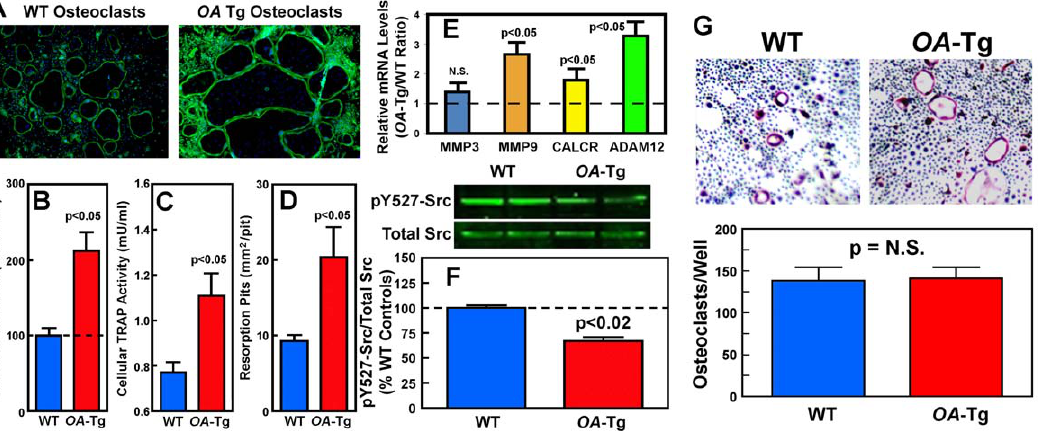
Figure 8. Effects of overexpression of OA on relative size of marrow-derived osteoclasts (A and B), and TRAP expression levels (C), size of resorption pits formed invitro (D), expression levels of bone resorption genes (E), cellular Src tyrosine-527 phosphorylation level (F), and number of TRAP-expressing osteoclast-like cells formed in response to the RANKL and m-CSF treatment (G). In A–F, marrow-derived osteoclasts were generated from treatment of unattached marrow cells of 12-weeks-old male adult OA -Tg mice and corresponding WT littermates with RANKL and m-CSF for 7 days. In A, to identify the size of osteoclasts, actin rings were stained with FITC-Palloidin and visualized under a fluorescent microscope. Results are shown in mean 6 SEM (n=3 each for each parameter). In G, marrow-derived osteoclasts were generated by treating unattached marrow cells of five 4-weeks-old female OA -Tg mice or four 4-weeks-old female WT littermates. Results are shown as mean 6